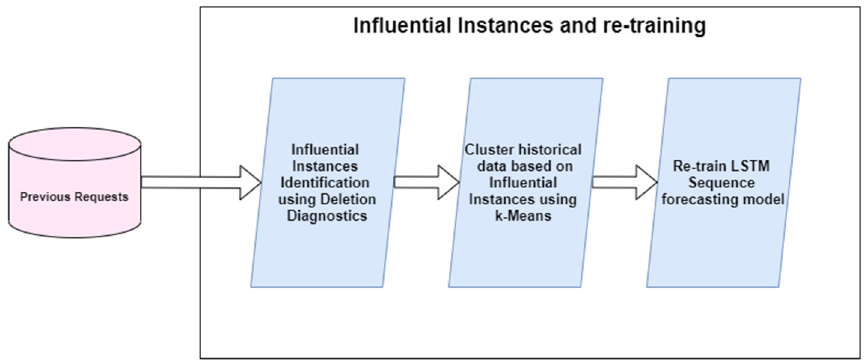
Figure 4. Influential instances identification workflow.